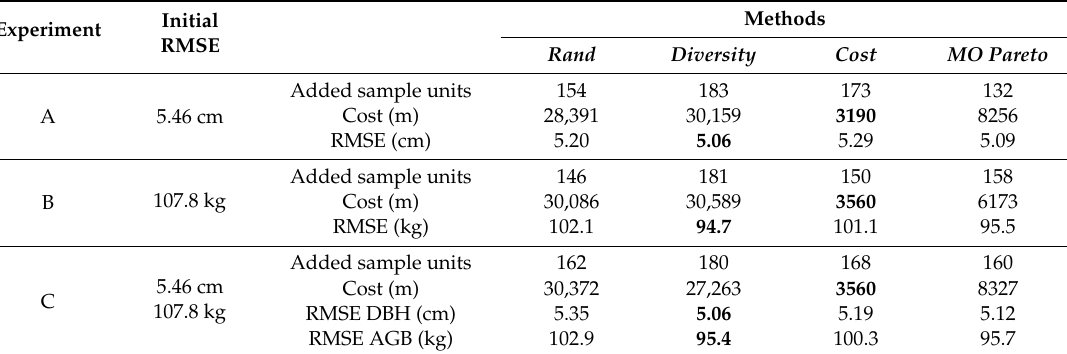
Table 3. Results obtained for Våler dataset (experiments A, B, and C). The initial RMSE is the RMSE obtained on Våler test set using only the Hadeland training set to build the model. The best results are highlighted in bold.